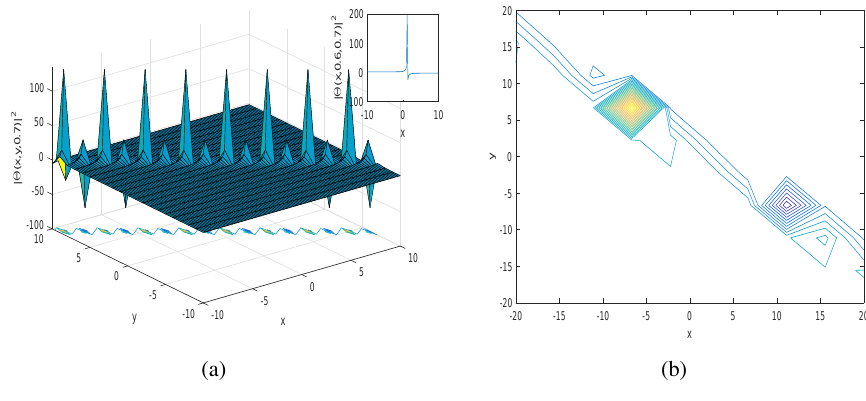
Figure 1 The (a) 2-, 3-dimensional and (b) contour surfaces of Eq. (3.5).